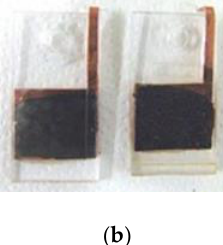
Figure A1. Schematic of experimental apparatus to investigate the effect of particle aggregation via the application of a magnetic field to the MCF rubber liquid.